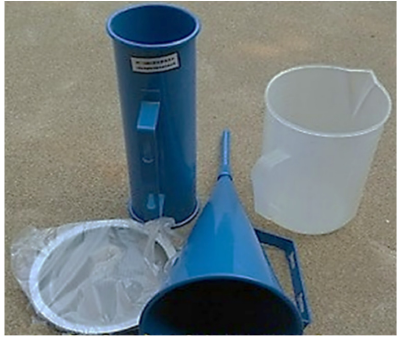
Figure 3. The 1006 mud viscometer.